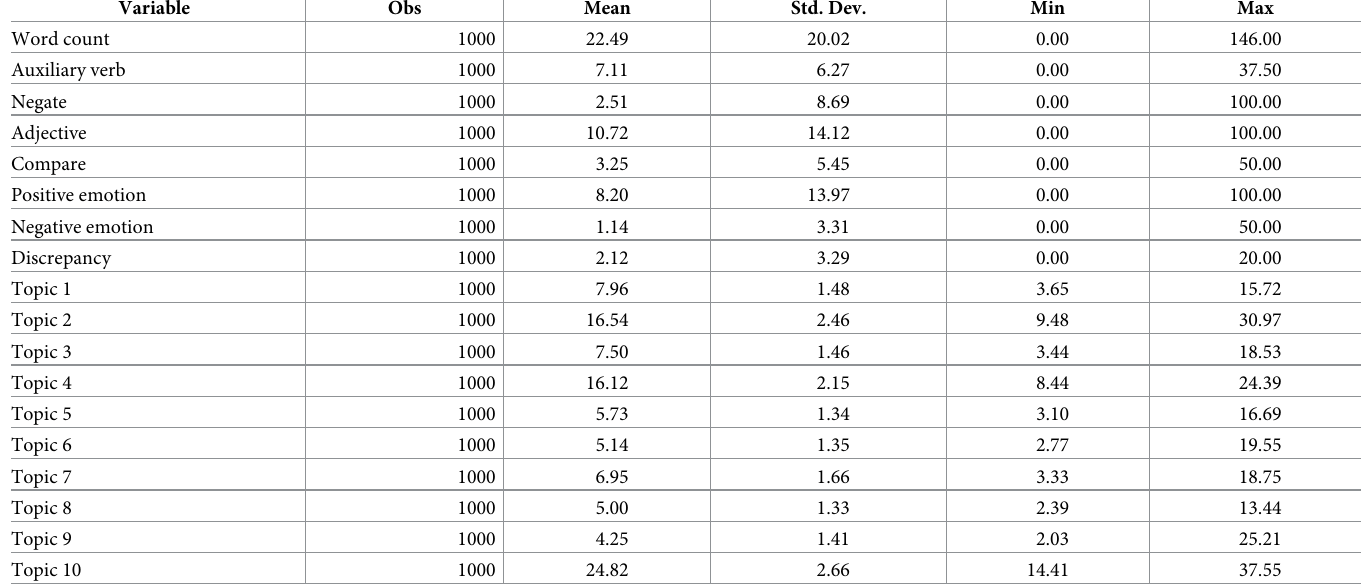
Table 5. Summary of language